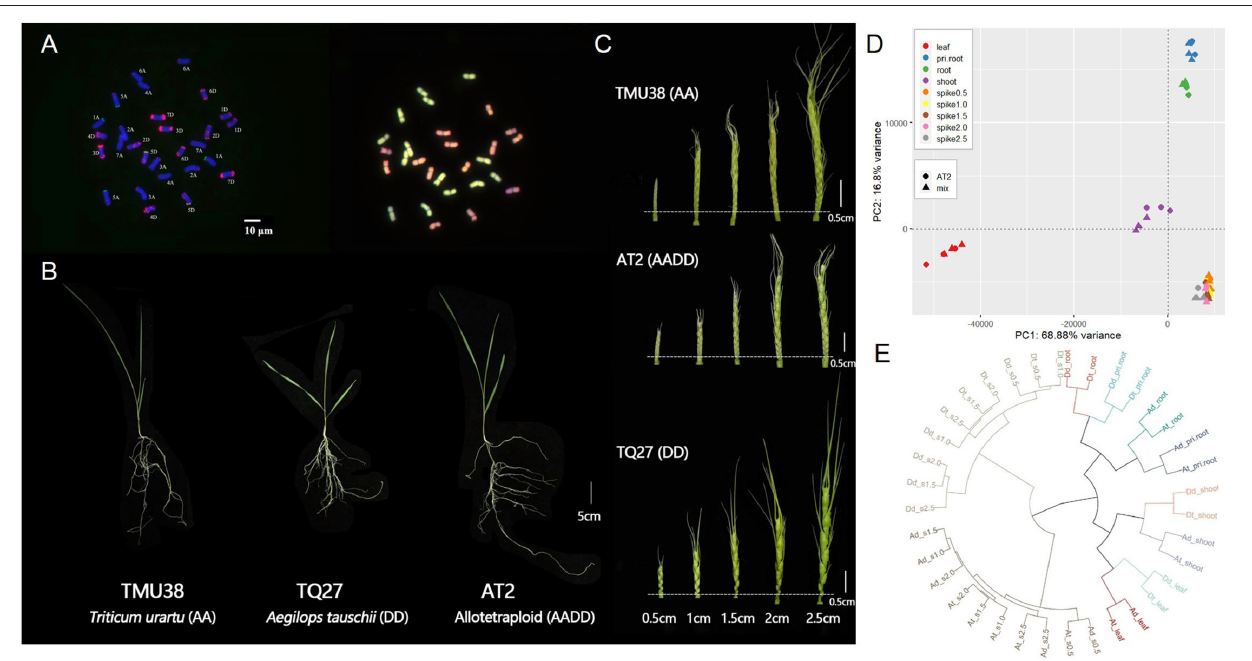
FIGURE 1 | Karyotypes, phenotypes, and spatio-temporal gene expression clustering in synthetic allotetraploid wheat (AT2, AADD) and corresponding parental species (TMU38 and TQ27 for AA and DD, respectively). (A) Euploid karyotypes of AT2 detected using fluorescent in situ hybridization (FISH, left) and genomic in situ hybridization (GISH, right). The DNA probes of FISH analysis are pSc119.2 (green) and pAS1 (red); (B) The phenotype of trefoil stage seedling of AT2 and parent species; (C) The spike morphology of AT2 and parental diploids from 0.5 to 2.5cm in length; (D) Principal component analysis (PCA) of transcriptomic expression profiles in AT2 and parental diploids (represented by “Mix”; see Materials and Methods). Colors and shapes denote the different tissues/stages and genotypes, respectively; (E) Hierarchical clustering of homoeolog expression in AT2 and parents. Ad and Dd denote the ortholog pairs in AA and DD diploid parents; At and Dt denote the homoeolog pairs in AT2. The bar of karyotype and phenotype photos is shown as white